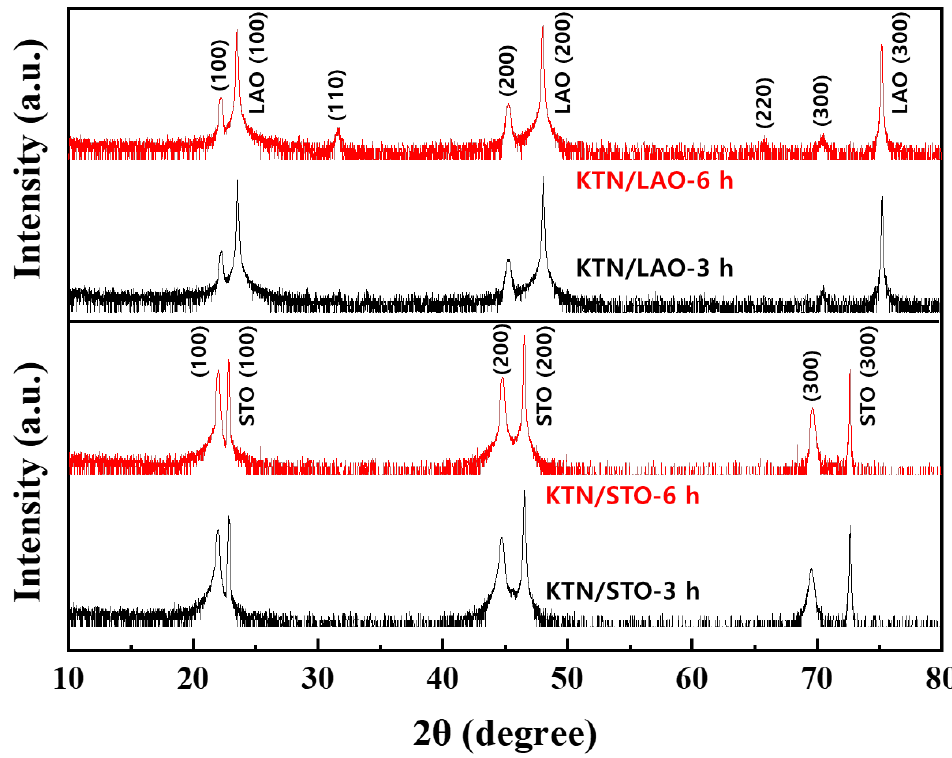
Figure 3. HRXRD patterns of KTN thin films deposited on LaAlO 3 and SrTiO 3 substrates for 3 and 6 h.